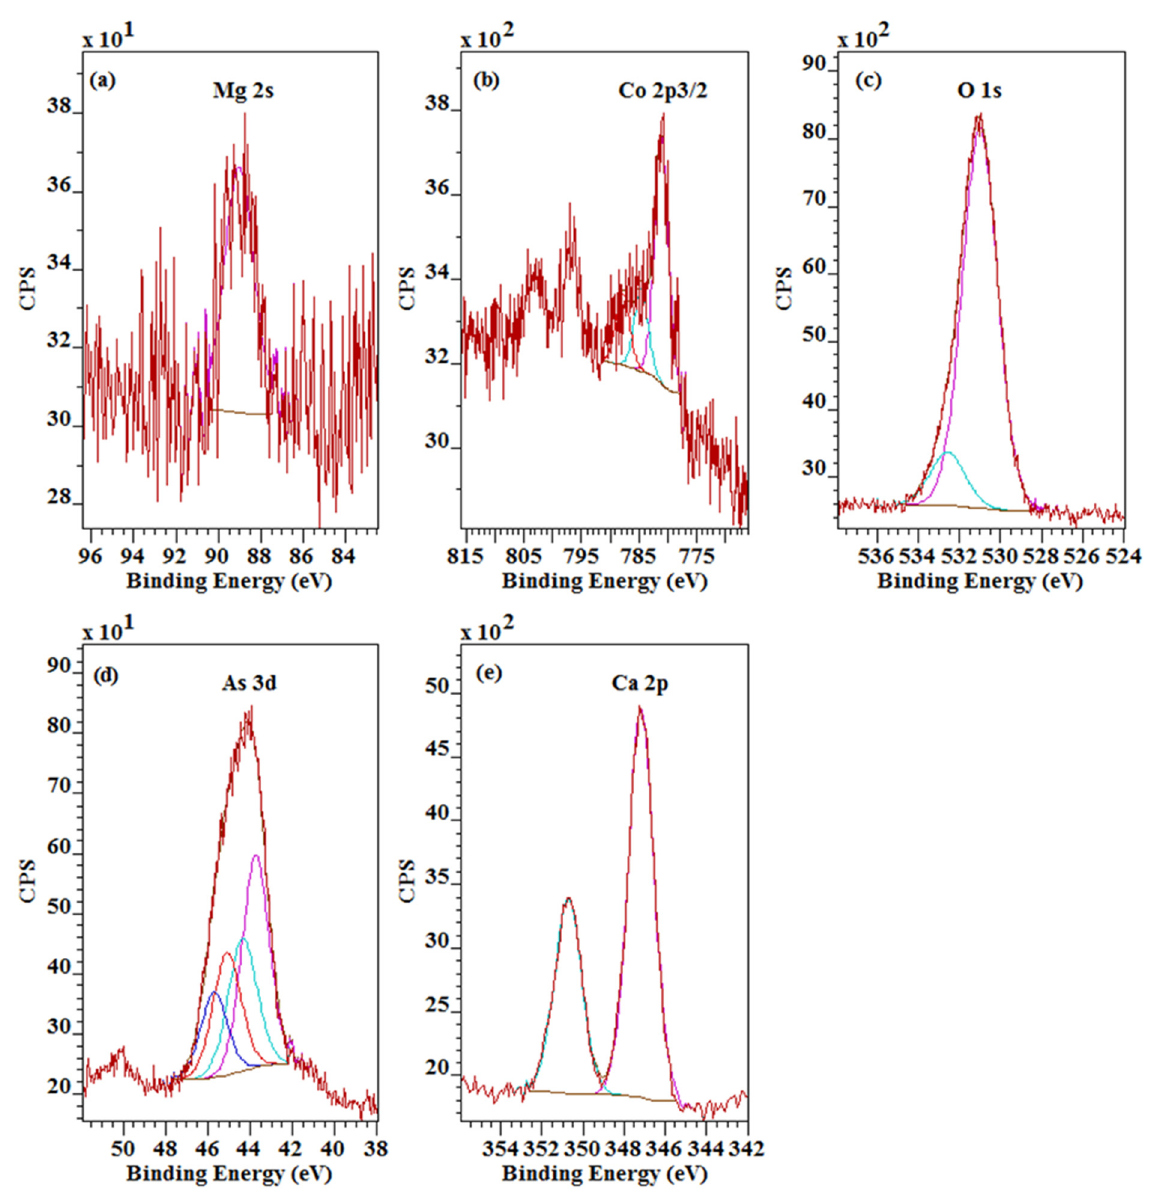
Figure 4. High resolution XPS spectra (Al K α , 150 W, 20 eV pass energy) of ( a ) Mg 2s, ( b ) Co 2p, ( c ) O 1s, ( d ) As 3d, and ( e ) Ca 2p of roselite.